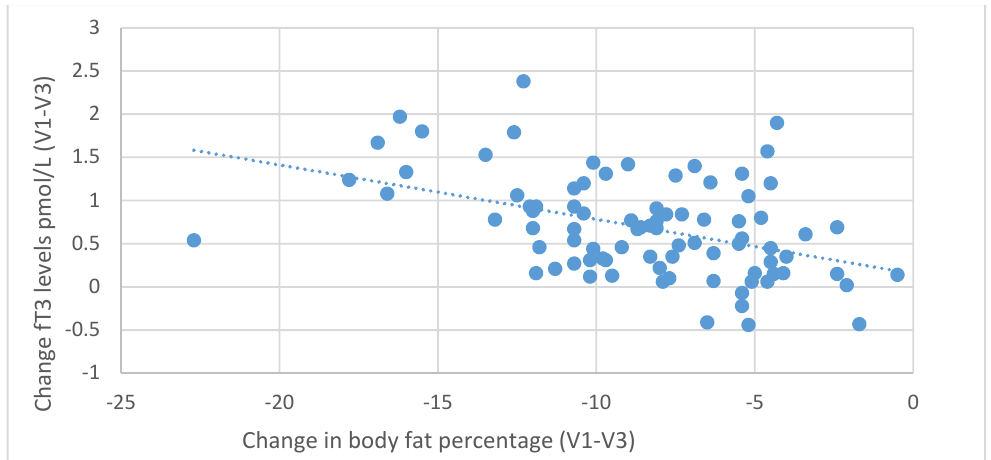
Figure 9. Correlations between differences in body fat content and changes in serum fT3 levels (between initial visit V1 and final visit V3).